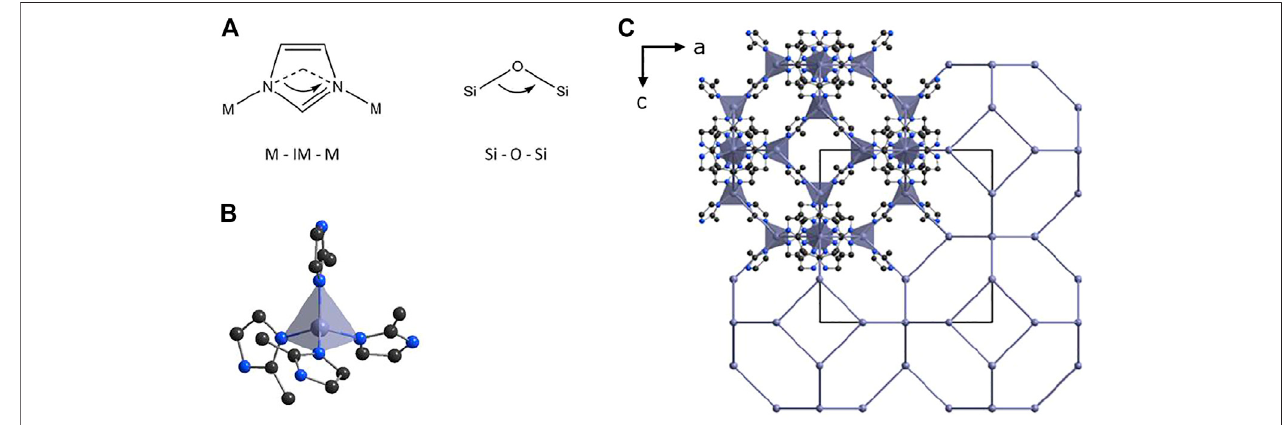
FIGURE 1 | (A) The bond angle in zeolitic imidazolate frameworks (ZIFs) is similar to the Si-O-Si bond angle in zeolites. (B) In ZIF-8, each Zn 2+ ion is tetrahedrally coordinatedbyfour2-methylimidazolatelinkers. (C) Viewalongthe b axisofthecrystalstructureofZIF-8.Thetopleftunitisshowncompletely,therestasareducednet of Zn 2+ -ions, revealing the porous nature of the